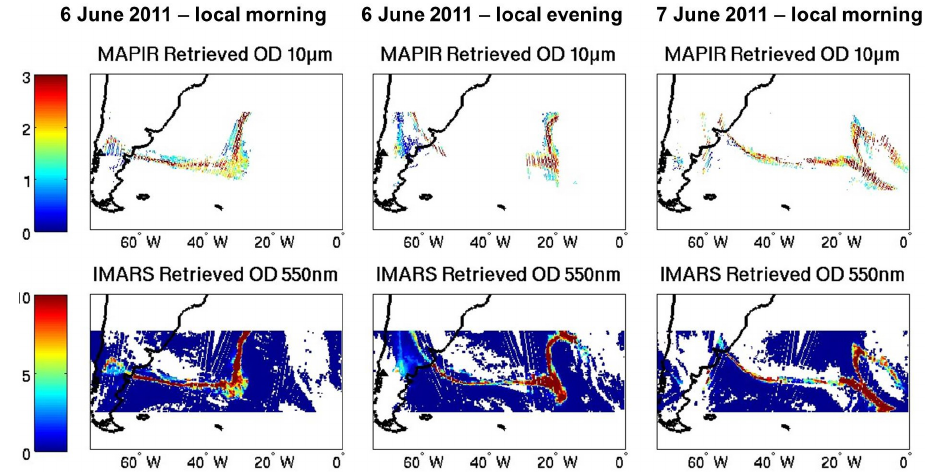
Figure 10. Same as Figure 9, left part, for the 6 June 2011 local morning (left) to the 7 June local morning